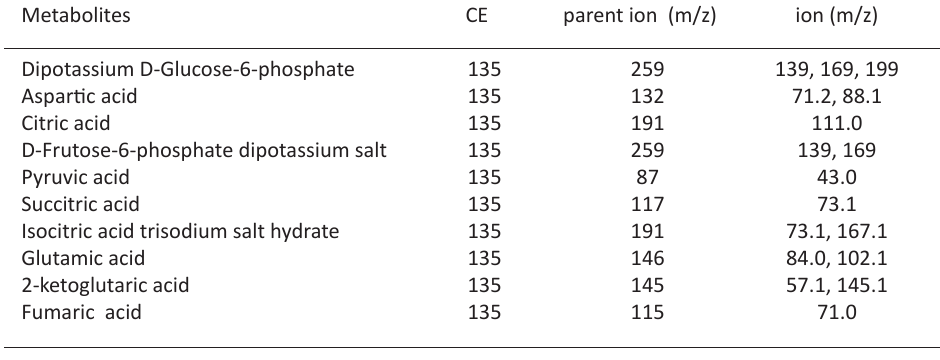
Table 3. The parameters of ten kinds of metabolites detected by triple quadrupole mass spectrometry